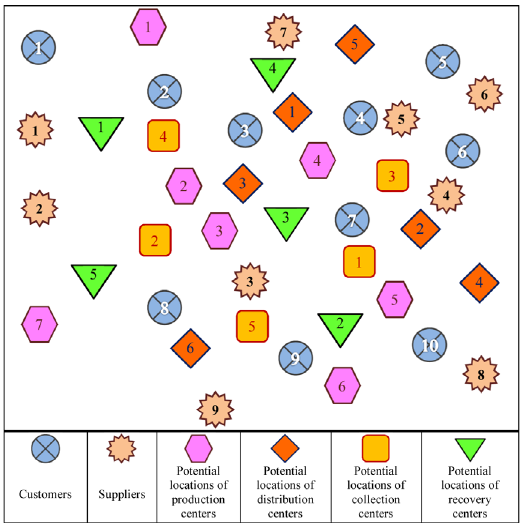
Fig. 3. The location of different elements of the